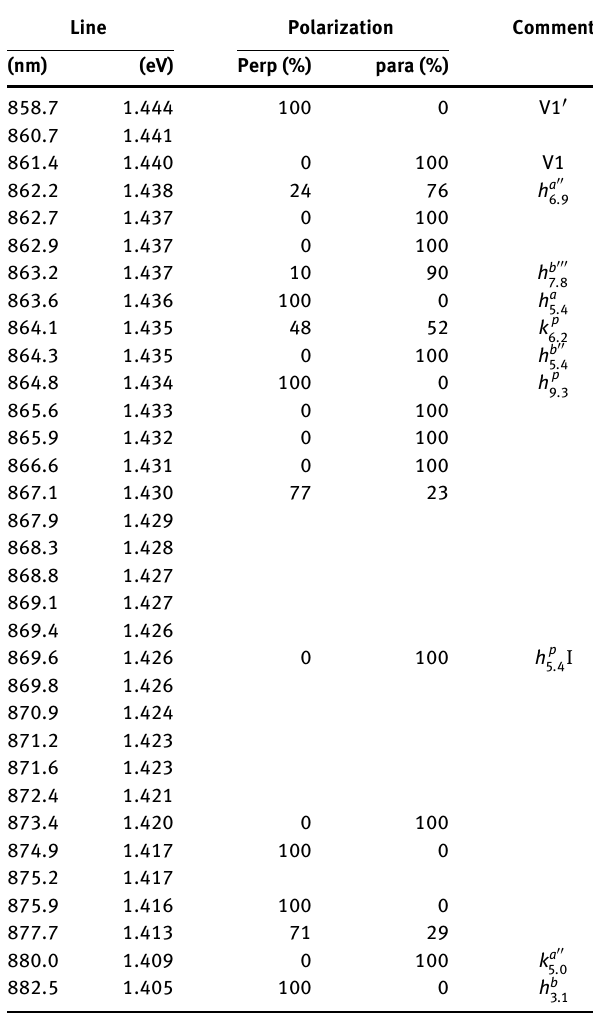
Table 3: The PL data for lines around the h isolated silicon vacancies in 4H-SiC. The polarization is normalized depending on the photon count and only shown for bright lines. Only mixed polarization with more than 5% in the minority component is shown. See Section 5.2 for more information about the assigned configurations in the comment column.